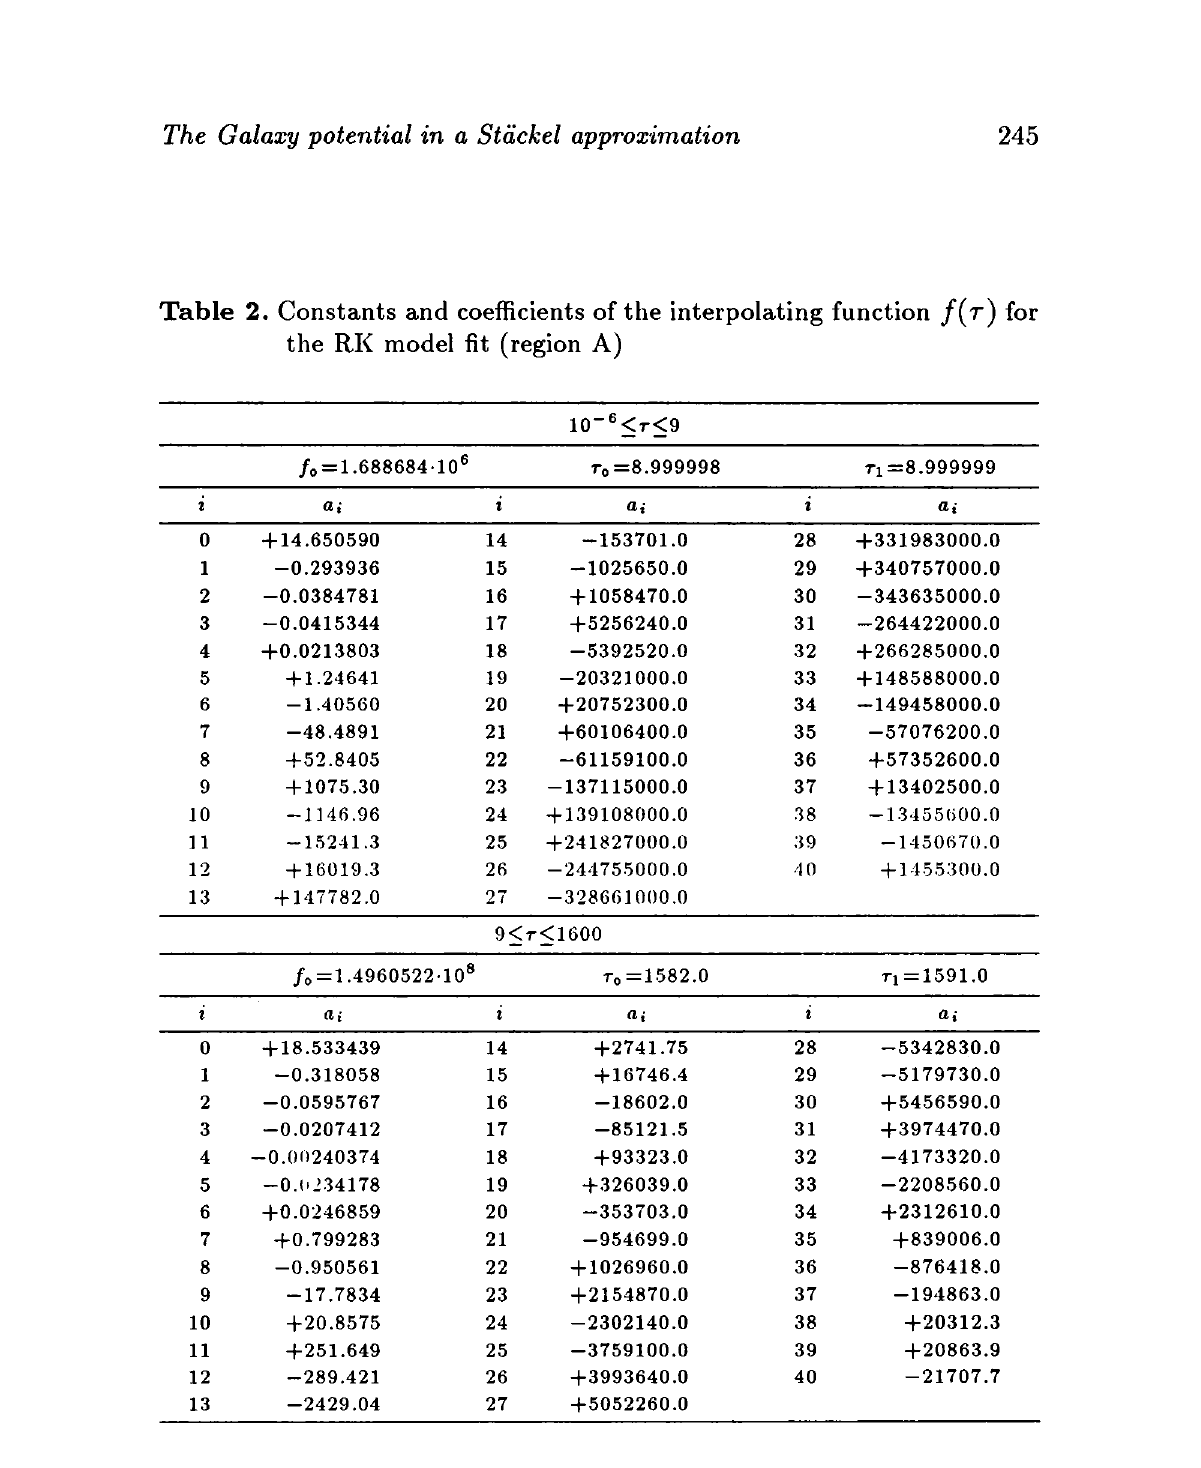
Table 2. Constants and coefficients of the interpolating function / ( T)